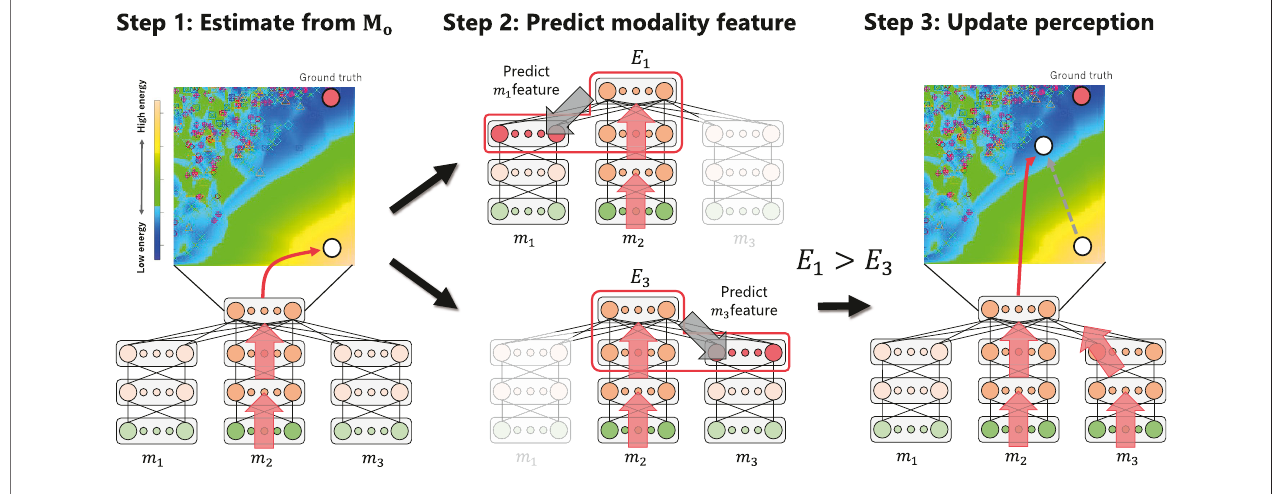
FIGURE 3 | Outline of the active perception method based on energy minimization of the